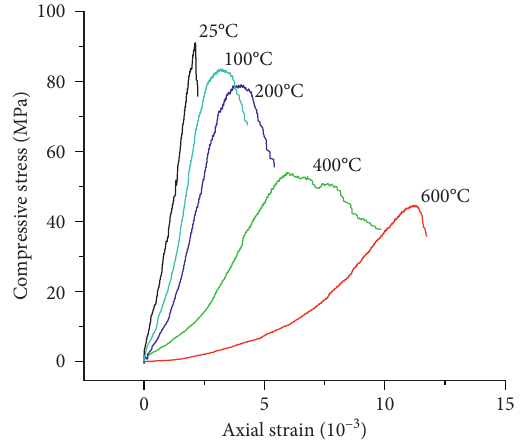
Figure 8: Stress-strain curve for uniaxial compressive strength test.